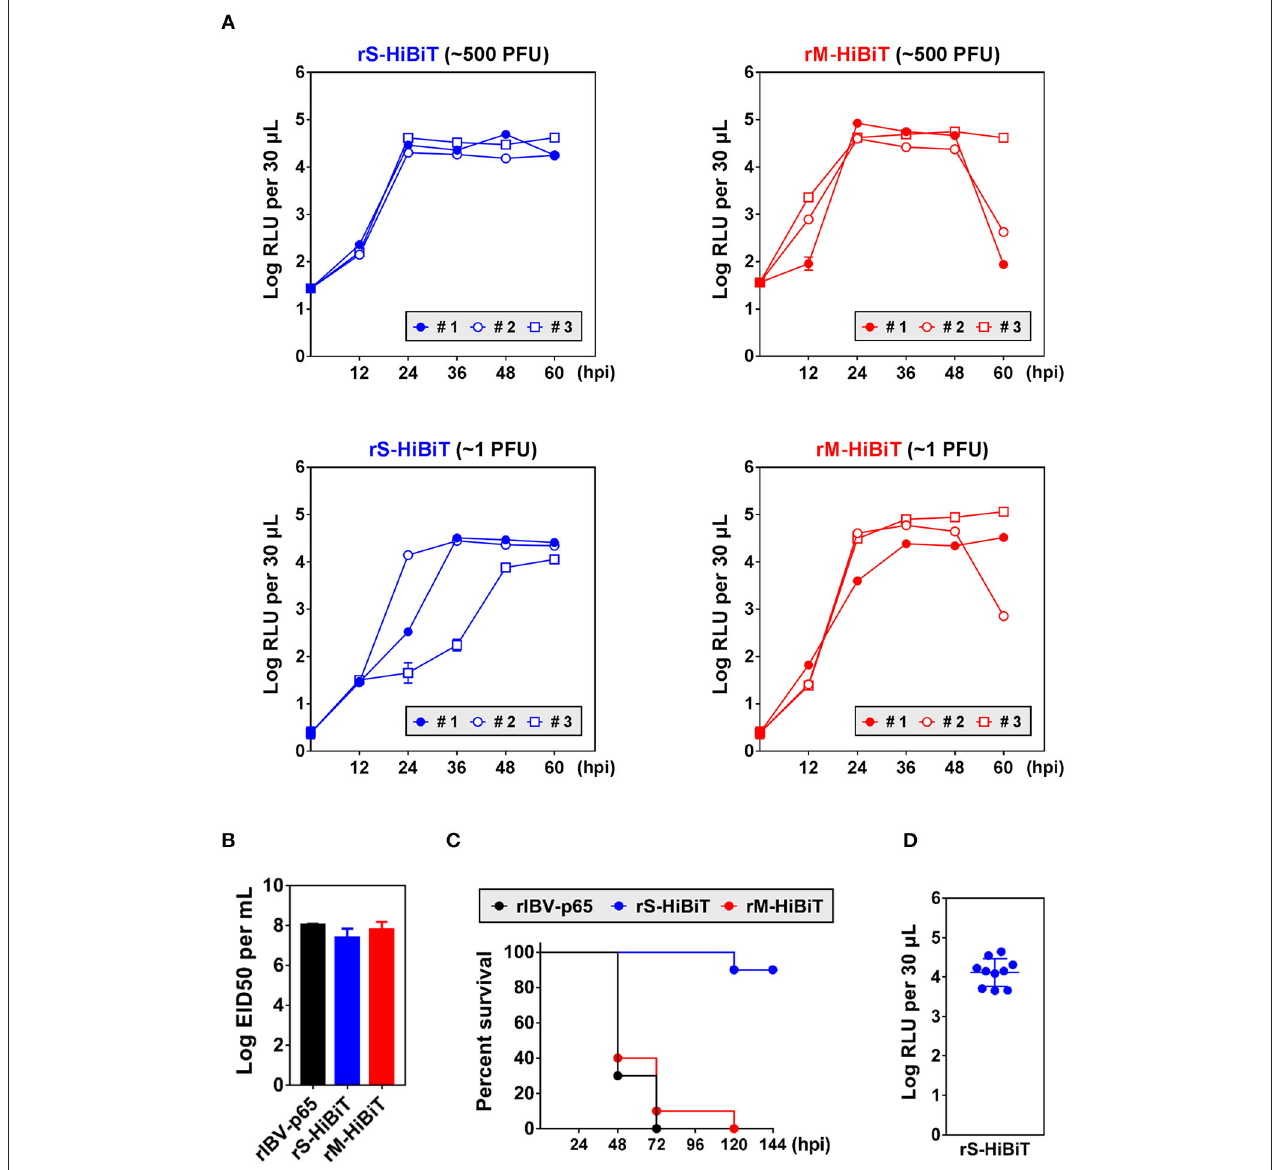
FIGURE 5 | Growth kinetics and attenuation of HiBiT-tagged rIBVs in embryonated chicken eggs. (A) Quantification of HiBiT protein in embryonated chicken eggs infected with HiBiT-tagged rIBVs. 10-days-old specific pathogen-free (SPF) embryonated chicken eggs were inoculated with about 500 or 1 plaque forming unit (PFU) of rS-HiBiT or rM-HiBiT. 100 µ L allantoic fluid was extracted every 12h. The background subtracted HiBiT luminescence was expressed in the unit of log RLU per 30 µ L. Three eggs (#1, #2, and #3) were used in each set. The experiment was repeated twice with similar results, and the result of one representative experiment is shown. (B) The 50% embryo infection doses (EID50) of the three rIBVs. Virus stocks of the rIBV-p65, rS-HiBiT, or rM-HiBiT were 10-fold serially diluted and 0.2ml diluted virus samples were injected into the allantoic cavities of 10-days old embryonated SPF chicken eggs. The eggs were incubated at 37 ◦ C for 5 days. The numbers of infected and uninfected embryos were determined and the EID50 was calculated. The bar chart shows the average results from three independent experiments with standard deviations. (C) Survival of the three rIBVs in chicken embryos. About 500 PFU of rIBV-p65, rS-HiBiT, or rM-HiBiT were injected into the allantoic cavities of 10-days old embryonated SPF chicken eggs. Ten eggs were used in each set. The embryos were incubated for 6 days and observed daily for signs of dead embryos. The percentage of survival was plotted against time. The experiment was repeated twice with similar results, and the result of one representative experiment is shown. (D) Expression of HiBiT-S protein in rS-HiBiT-infected chicken embryos at 144 hpi in (C) . The allantoic fluid was extracted and HiBiT luminescence was determined as in (A) .